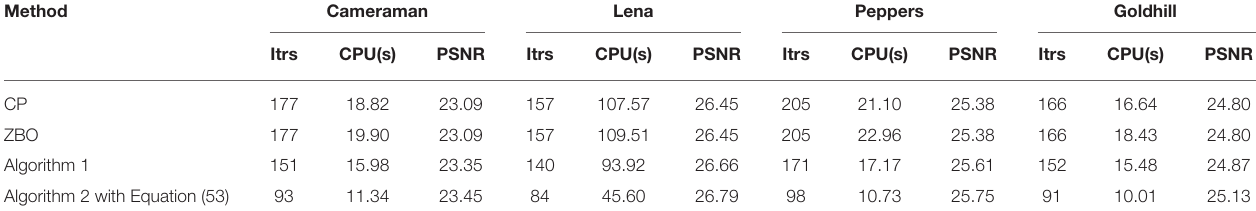
Algorithm 1 Algorithm 2 with Equation (53) Algorithm 2 with Equation (55)